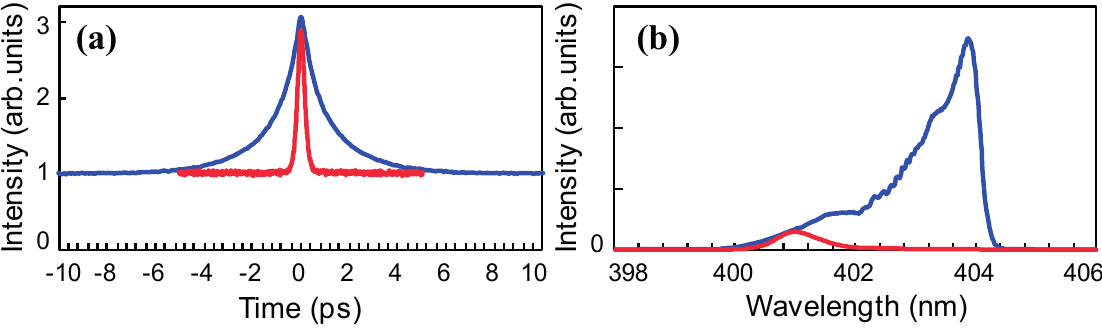
Figure 2. ( a ) Intensity autocorrelation traces for optical pulses from a GaInN MLLD with negative intracavity GVD measured without a bandpass filter (blue trace), and with a bandpass filter (red trace); ( b ) Corresponding optical spectra without a bandpass filter (blue trace), and with a bandpass filter (red